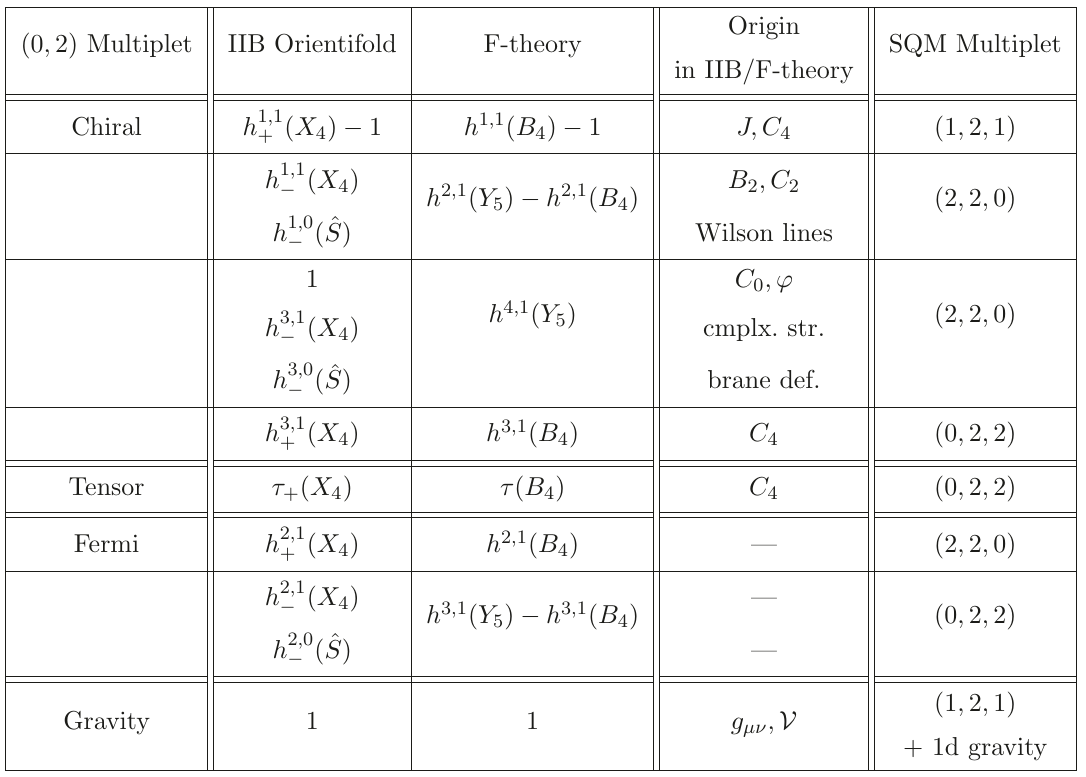
Table 2 . Moduli and gravitational sector of IIB orientifolds on Calabi-Yau fourfold X 4 as well as of F-theory on Y 5 in terms of 2d (0 , 2) multiplets. The subscripted signs in the second column indicate the orientifold even and odd parts of the cohomology. The fourth column contains the origin of the modes from the bosonic sector of IIB/F-theory. The last column indicates the dual 1d N = 2 SQM multiplets obtained from M-theory on the same Y 5